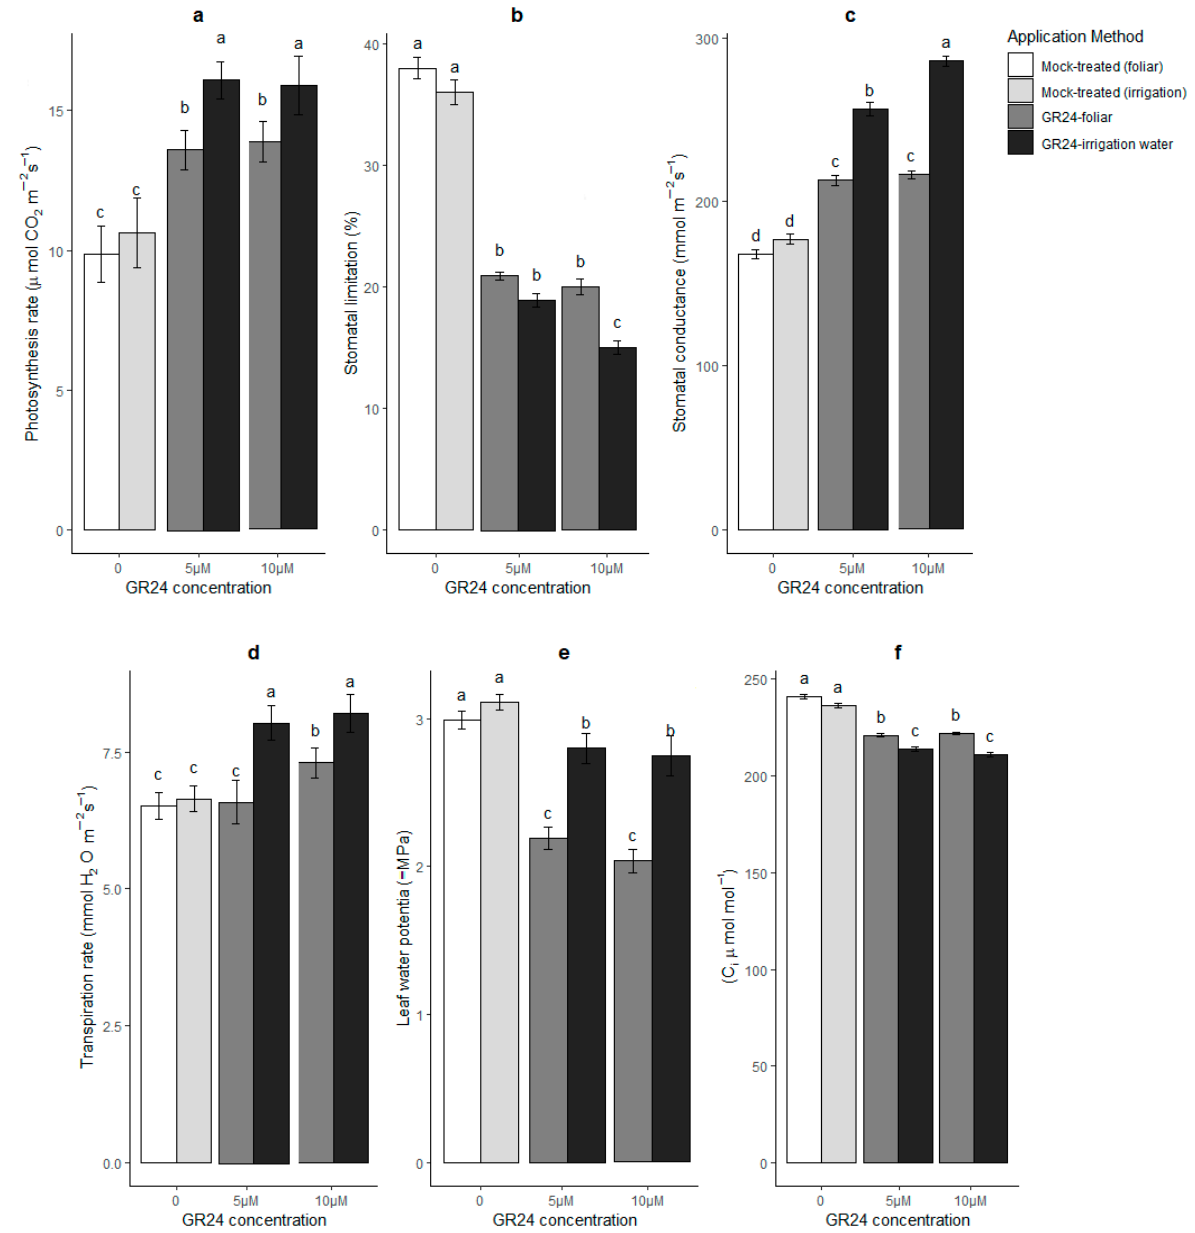
Figure 1. Photosynthesis rate ( a ), stomatal limitation ( b ), stomatal conductance ( c ), transpiration rate ( d ), leaf water potential ( e ) and substomatal CO 2 levels (C i ) ( f ) in wheat plants in response to two methods of GR24 application under drought stress conditions. Mock-treated plants in these graphs were equally drought-stressed but received a water and acetone solution; for irrigated control values, see Supplementary Materials Figure S1. Each value represents the mean ± SE ( n = 4, each replicate the pool of four plants). Different letters on top of bars indicate significantly different means for p ≤ 0.05 (LSD test).